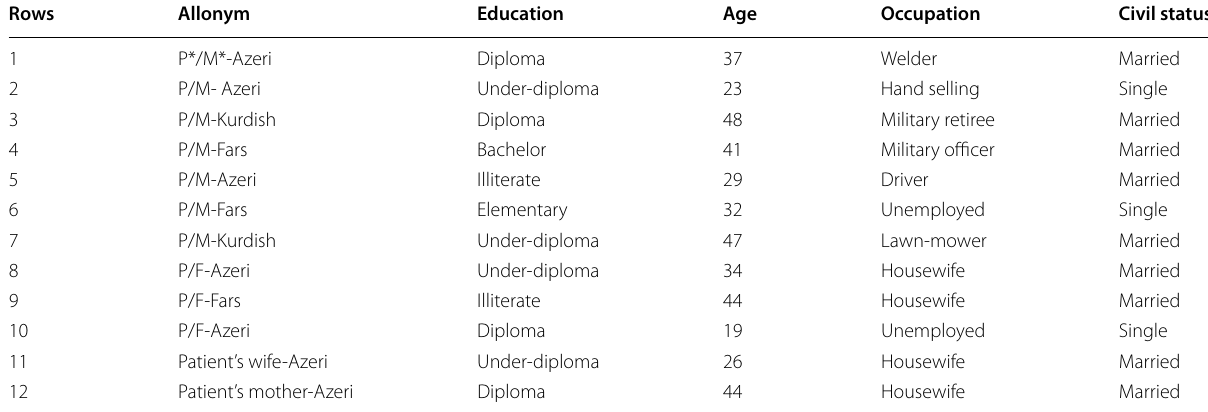
P patient, M male, F female